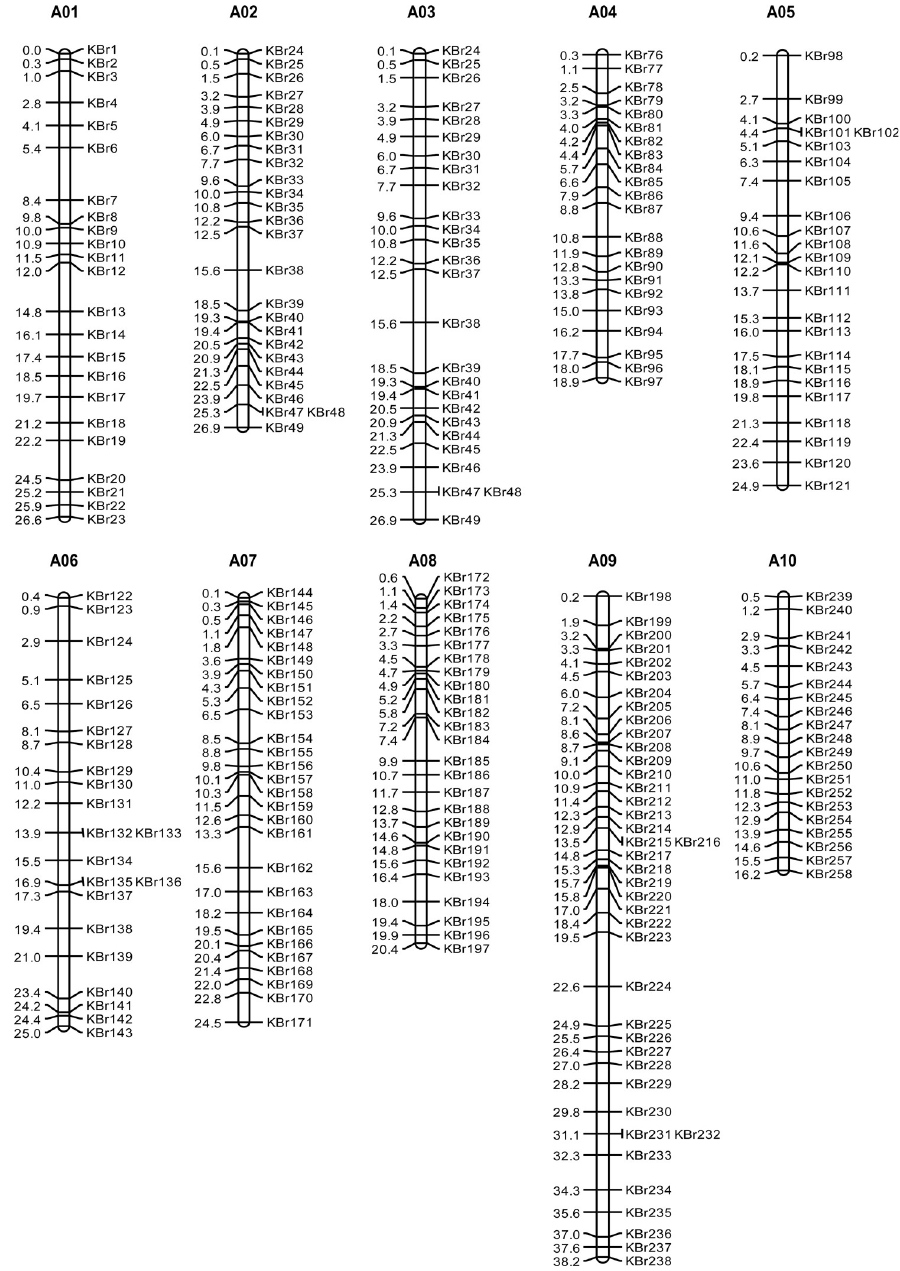
Fig 3. Physical map position of 258 KASP-SNP markers in the Chinese cabbage genome. Marker names are indicated on the right side and physical positions (Mb) on the left side of each chromosome.